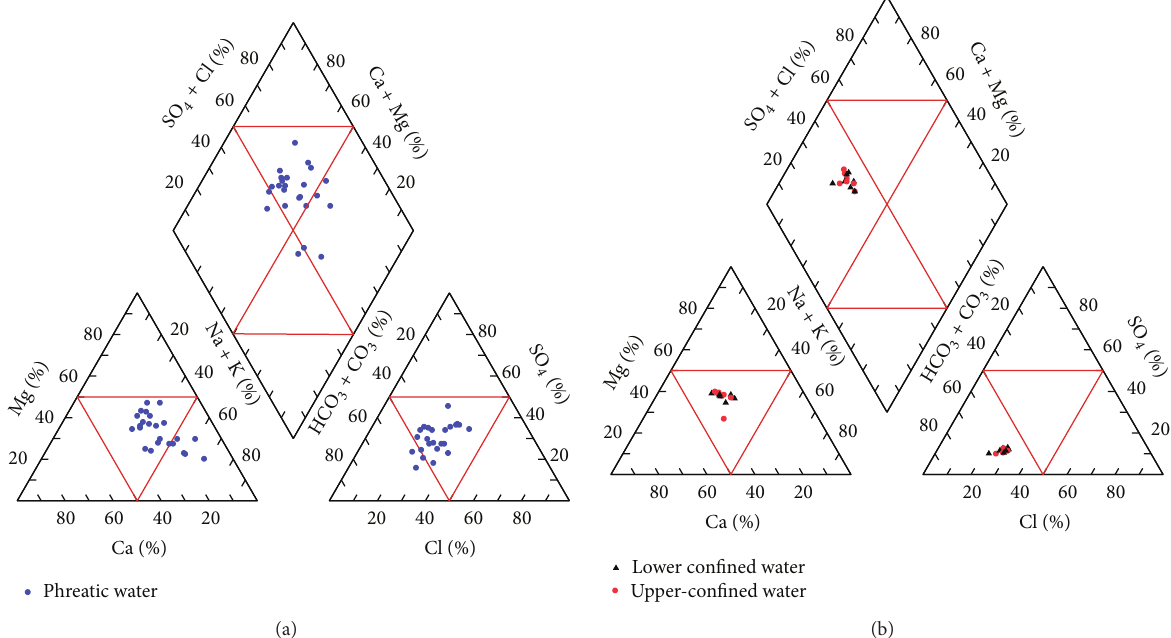
Figure 2: The piper diagrams for the phreatic water samples (a) and the confined water samples (b).